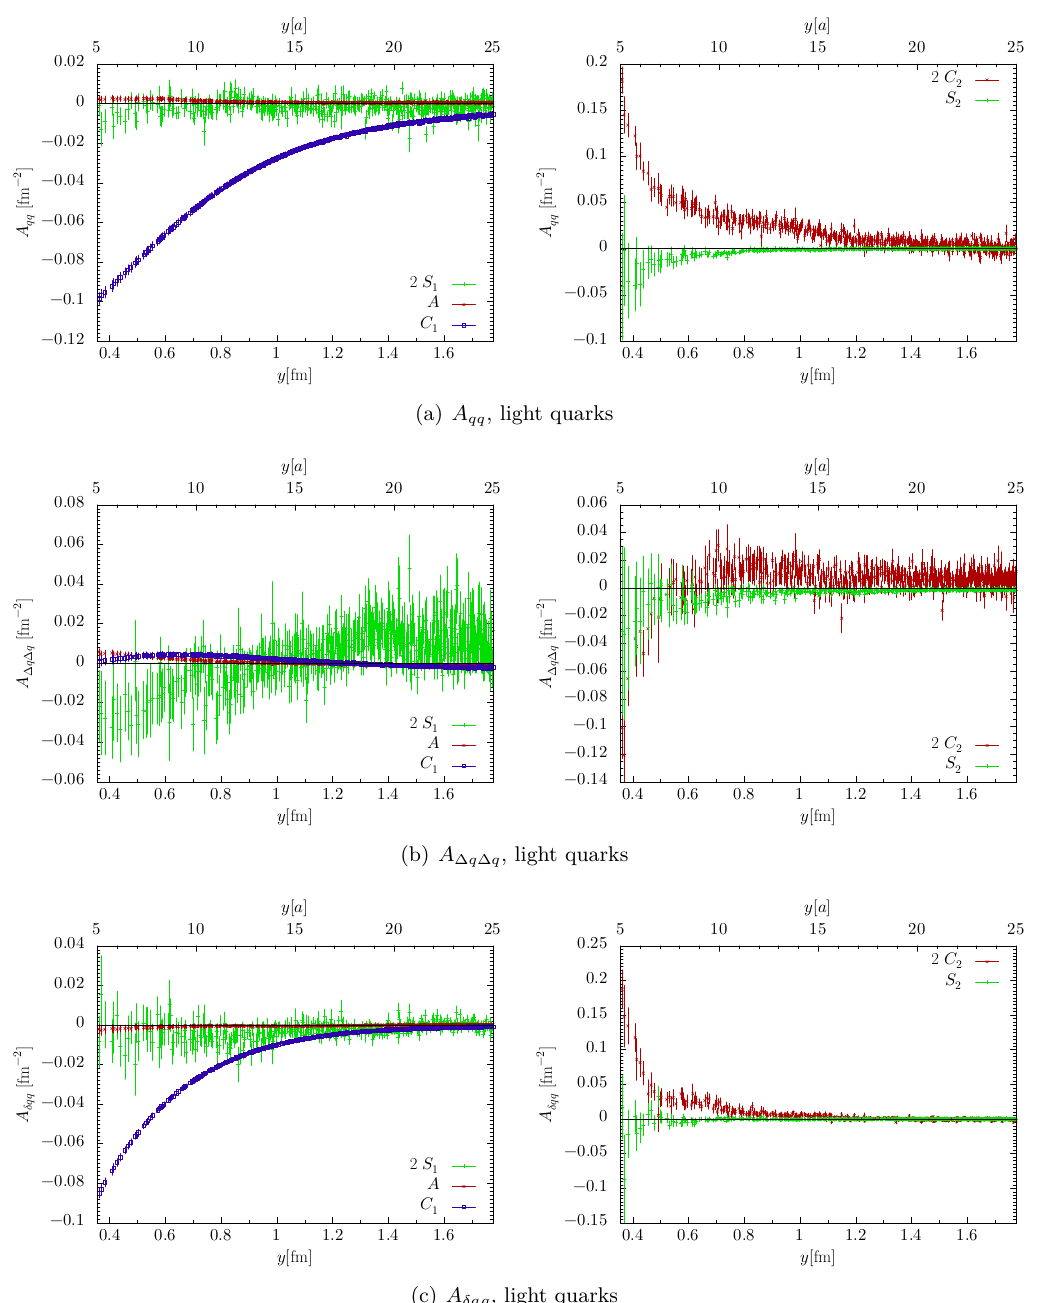
Figure 14 . Contributions of the different lattice graphs to twist-two functions for light